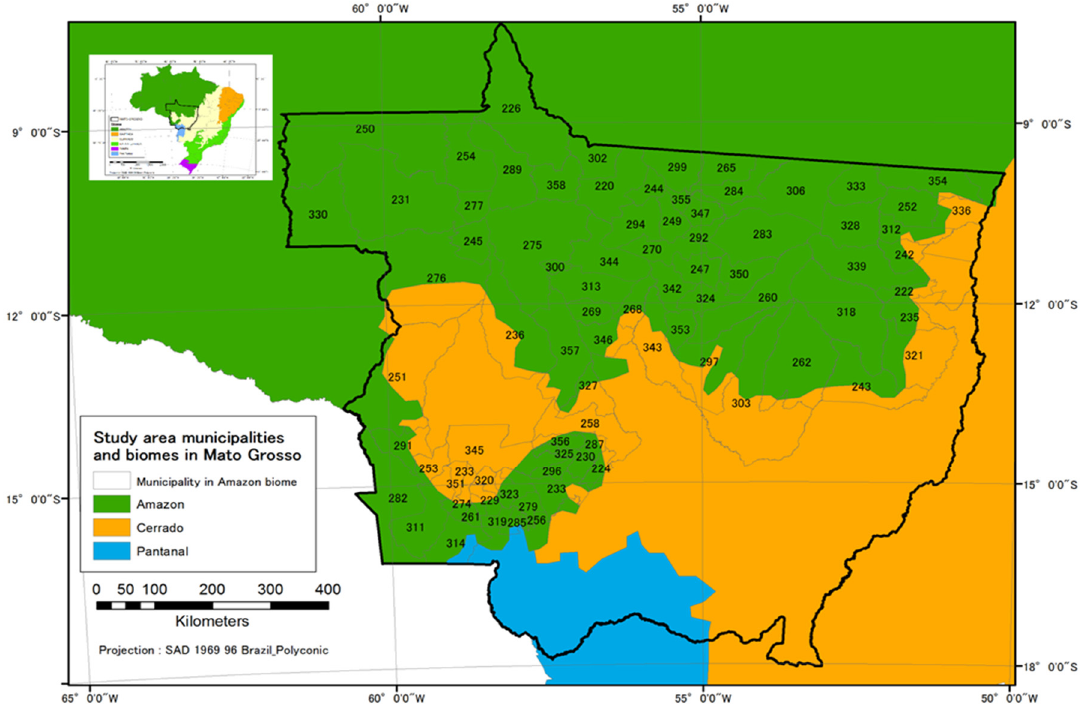
Figure 3. Study area municipalities (See Appendix 1 for the names of municipalities represented by numbers in this and subsequent maps) in Mato Grosso.